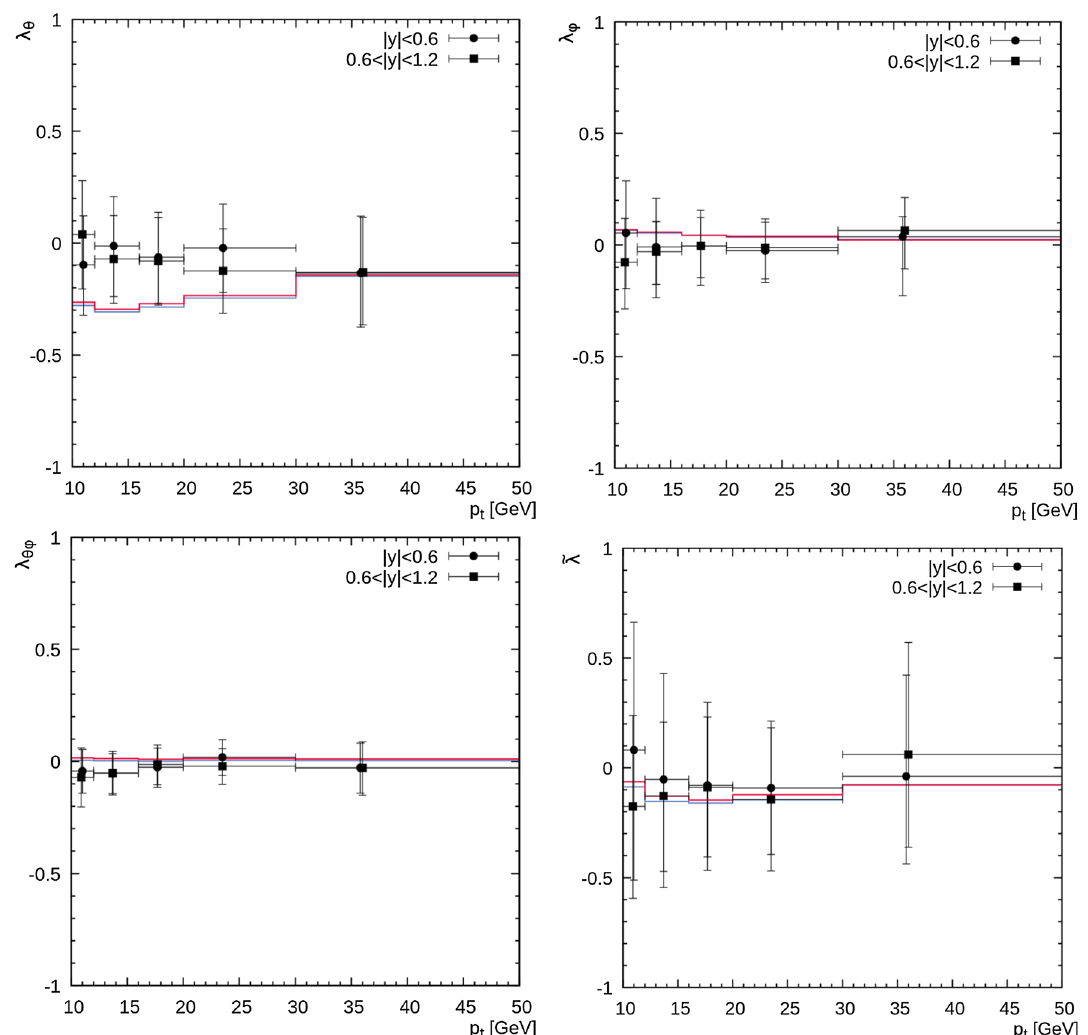
Fig. 11 The polarization parameters λ θ , λ φ , λ θφ and ˜ λ of the ϒ( 1 S ) mesonscalculatedintheCSframeasfunctionsofitstransversemomen- √ s = 7 TeV. The A0 gluon density is used. The blue and red tum at